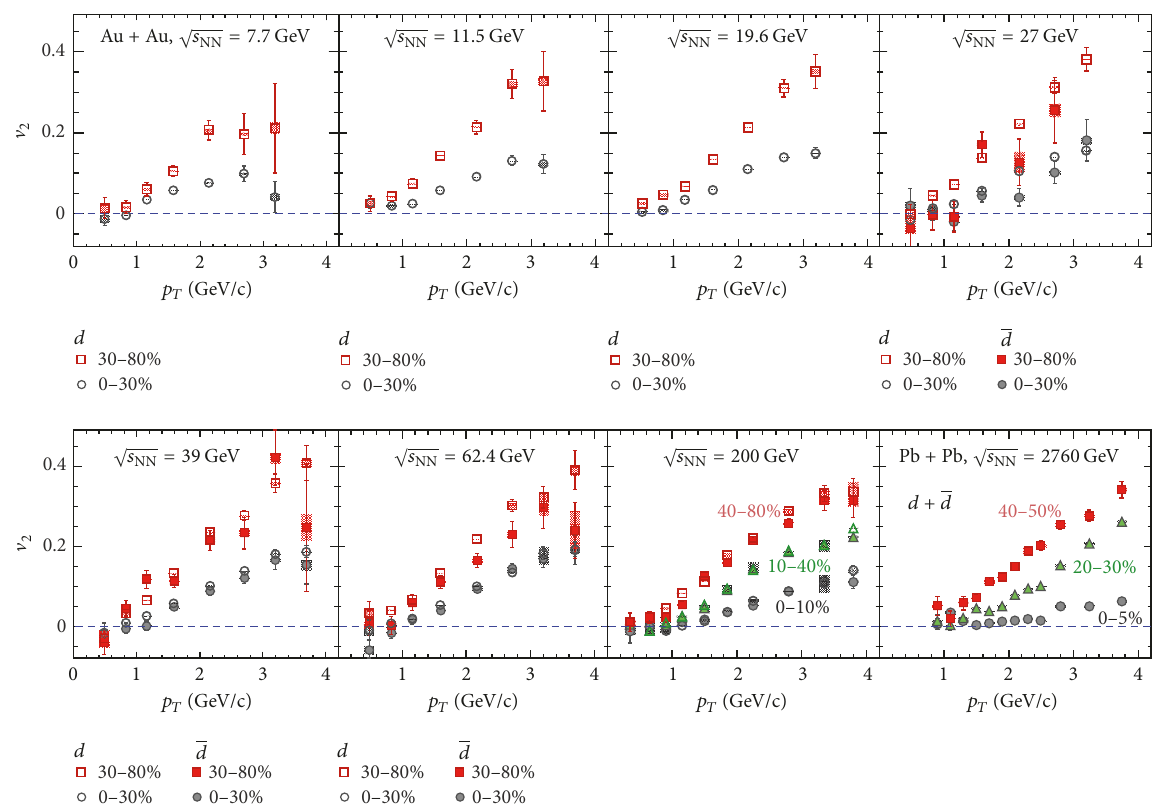
Figure 5: Centrality dependence of V 2 of 𝑑(𝑑) as a function of 𝑝 𝑇